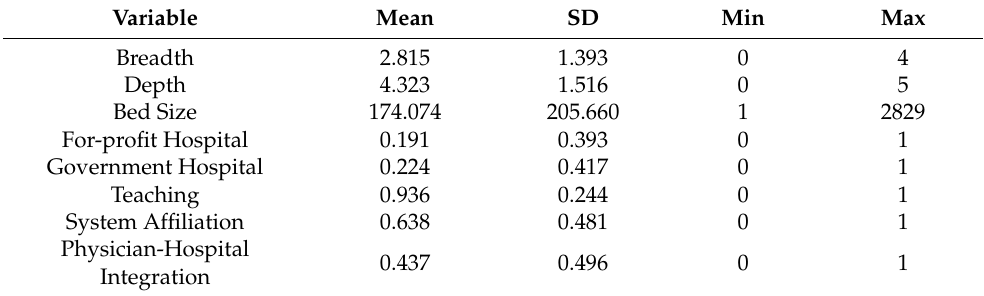
Table 1. Descriptive